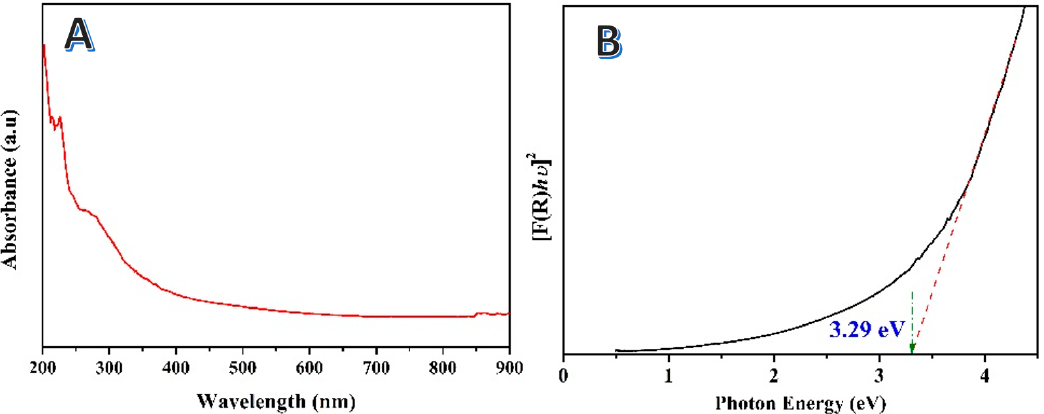
Figure 9. UV-vis spectra for the prepared photocatalyst from corn stalk pith hydrothermally treated by 1.0 M KOH at 170 °C for 3 h and calcined at 600 °C; ( A ), and Tauc plots for determination the band gap energies for the prepared sample; ( B ).